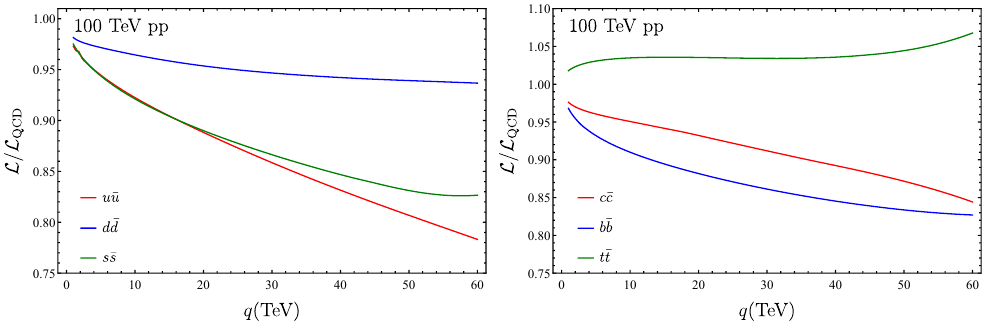
Figure 6 . Quark anti-quark luminosity in the full unbroken SM, divided by their values assuming pure QCD evolution only.